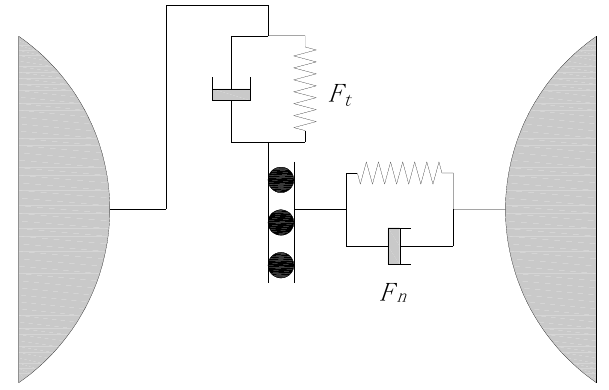
Figure 2. Contact model based on softball model.